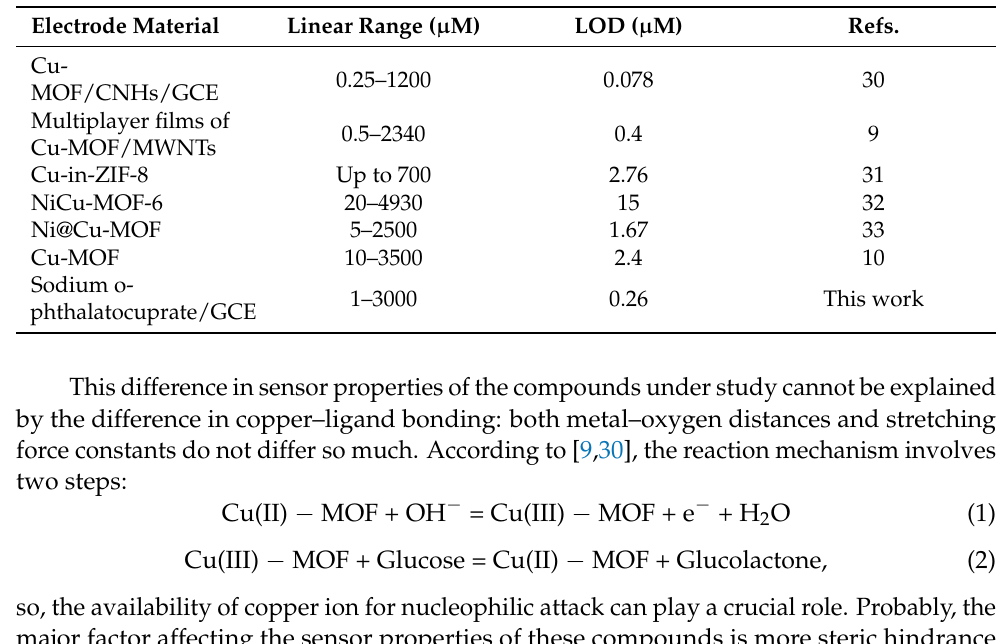
Table 5. Electrochemical performance of the sodium o-phthalatocuprate/GC electrode and similar materials for enzyme-free glucose